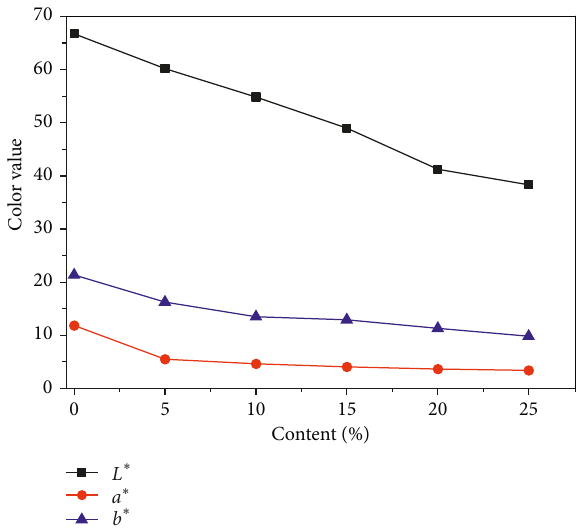
Figure 4: Effect of different vanadium-titanium slags on the color of ceramics.